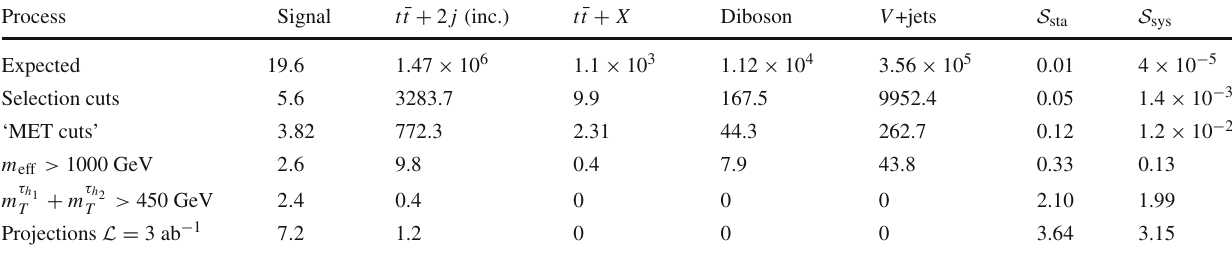
Table 1 Cut flow of expected signal and background events for a LHC from Eqs. (4) and (5), the latter with a background systematic uncer- √ s = 14 TeV and a total integrated luminos- center-of-mass-energy of tainty of 30%. A QCD multijet estimation of 0.3 events [32] is ity of L = 1 ab − 1 , considering a hadronic τ h -tagging efficiency of 90%. Selection cuts from Eq. (2) and ‘MET cuts’ from Eq. (3). Significances